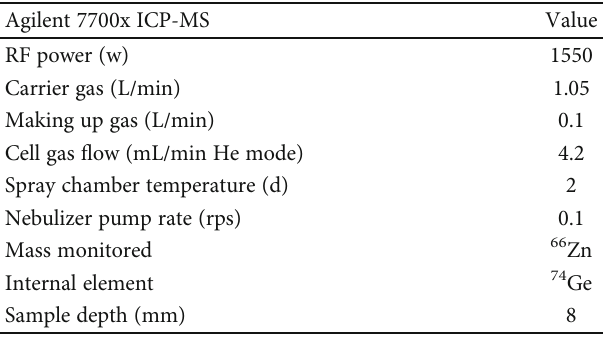
Table 2: Main operation parameters of